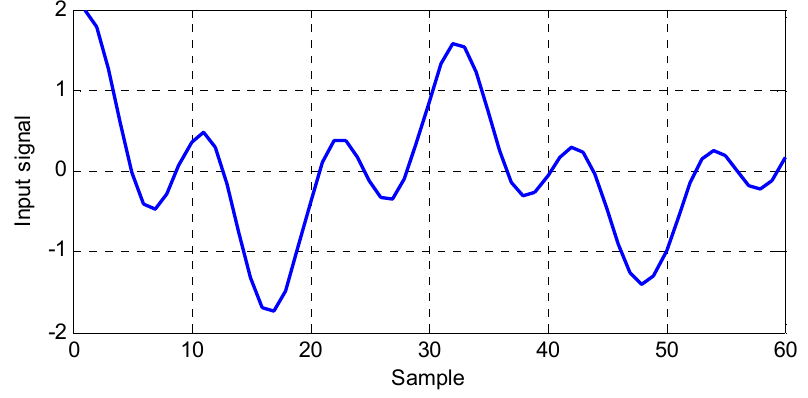
Figure 4. The input signal of test system 2.